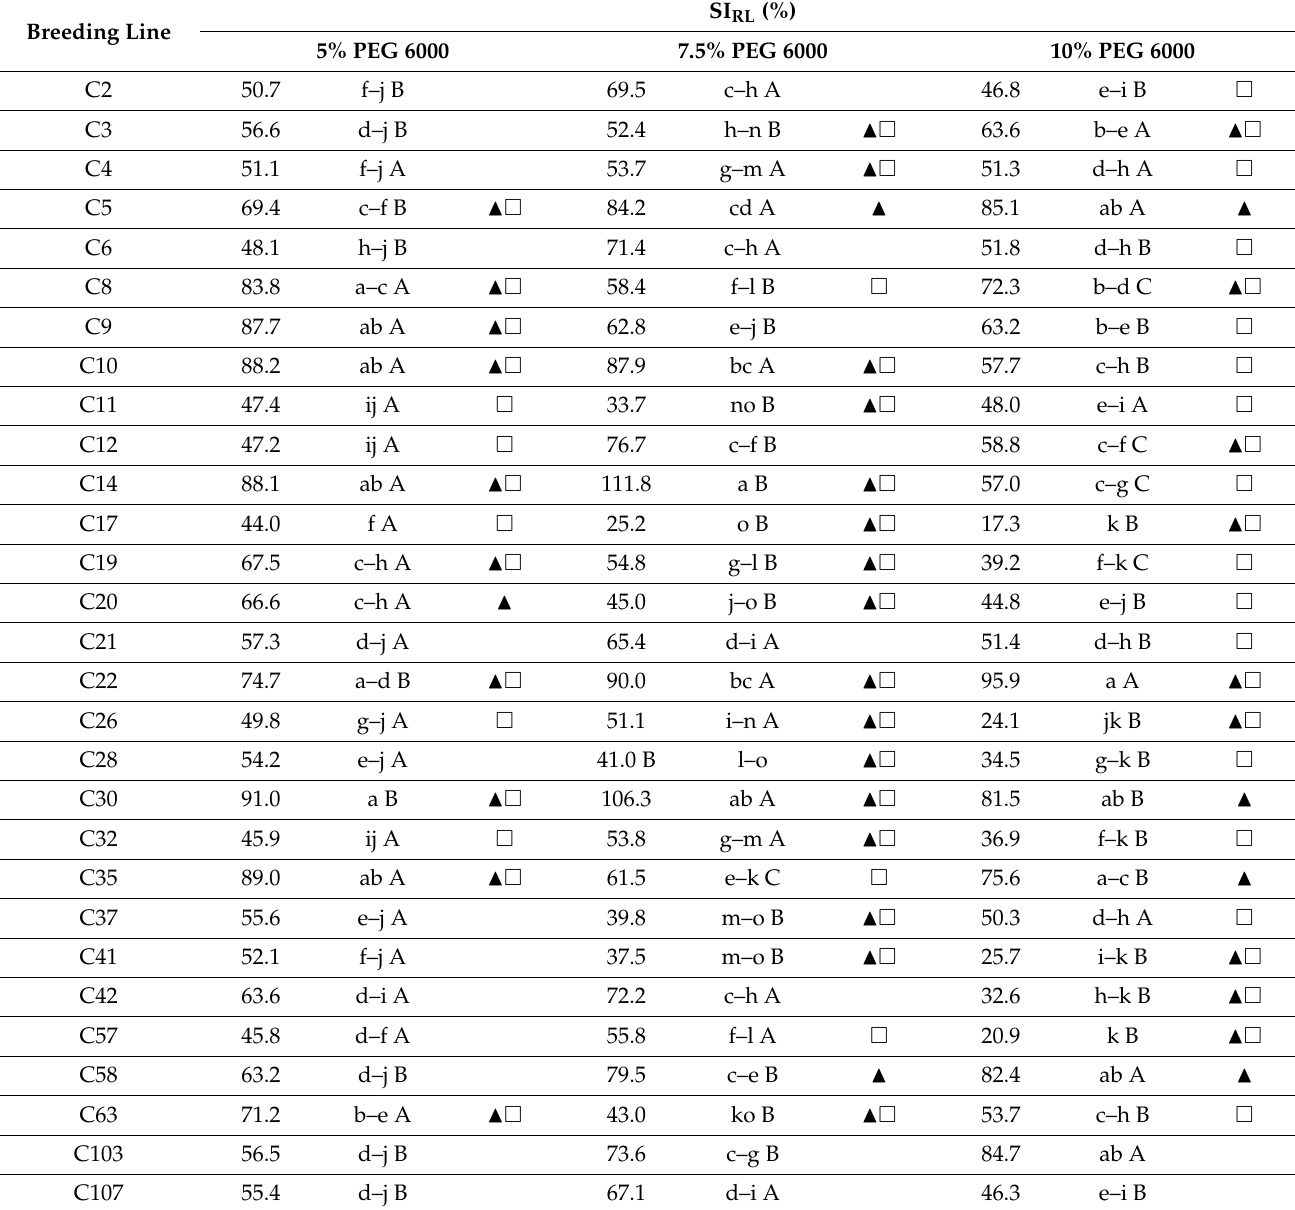
Table 4. Root length SI (SI RL ) values of potato genotypes under osmotic stress induced by PEG 6000 added to the medium at levels of 5.0%, 7.5% and